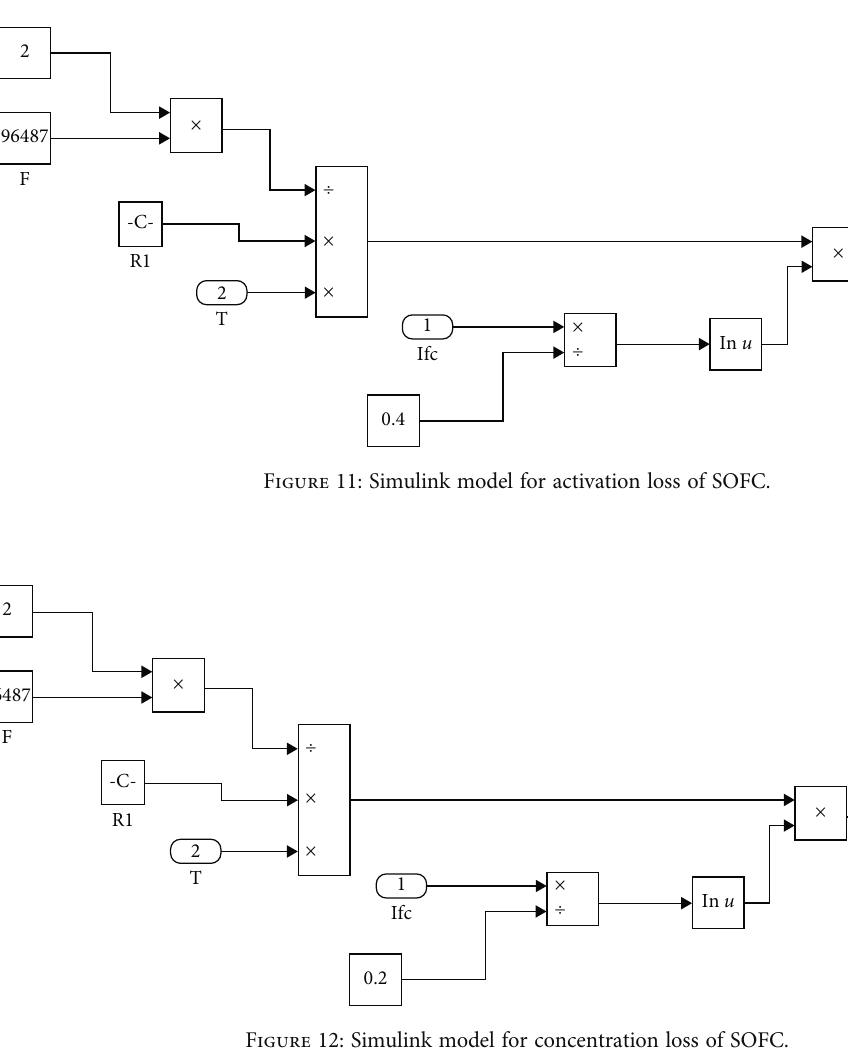
Figure 12: Simulink model for concentration loss of